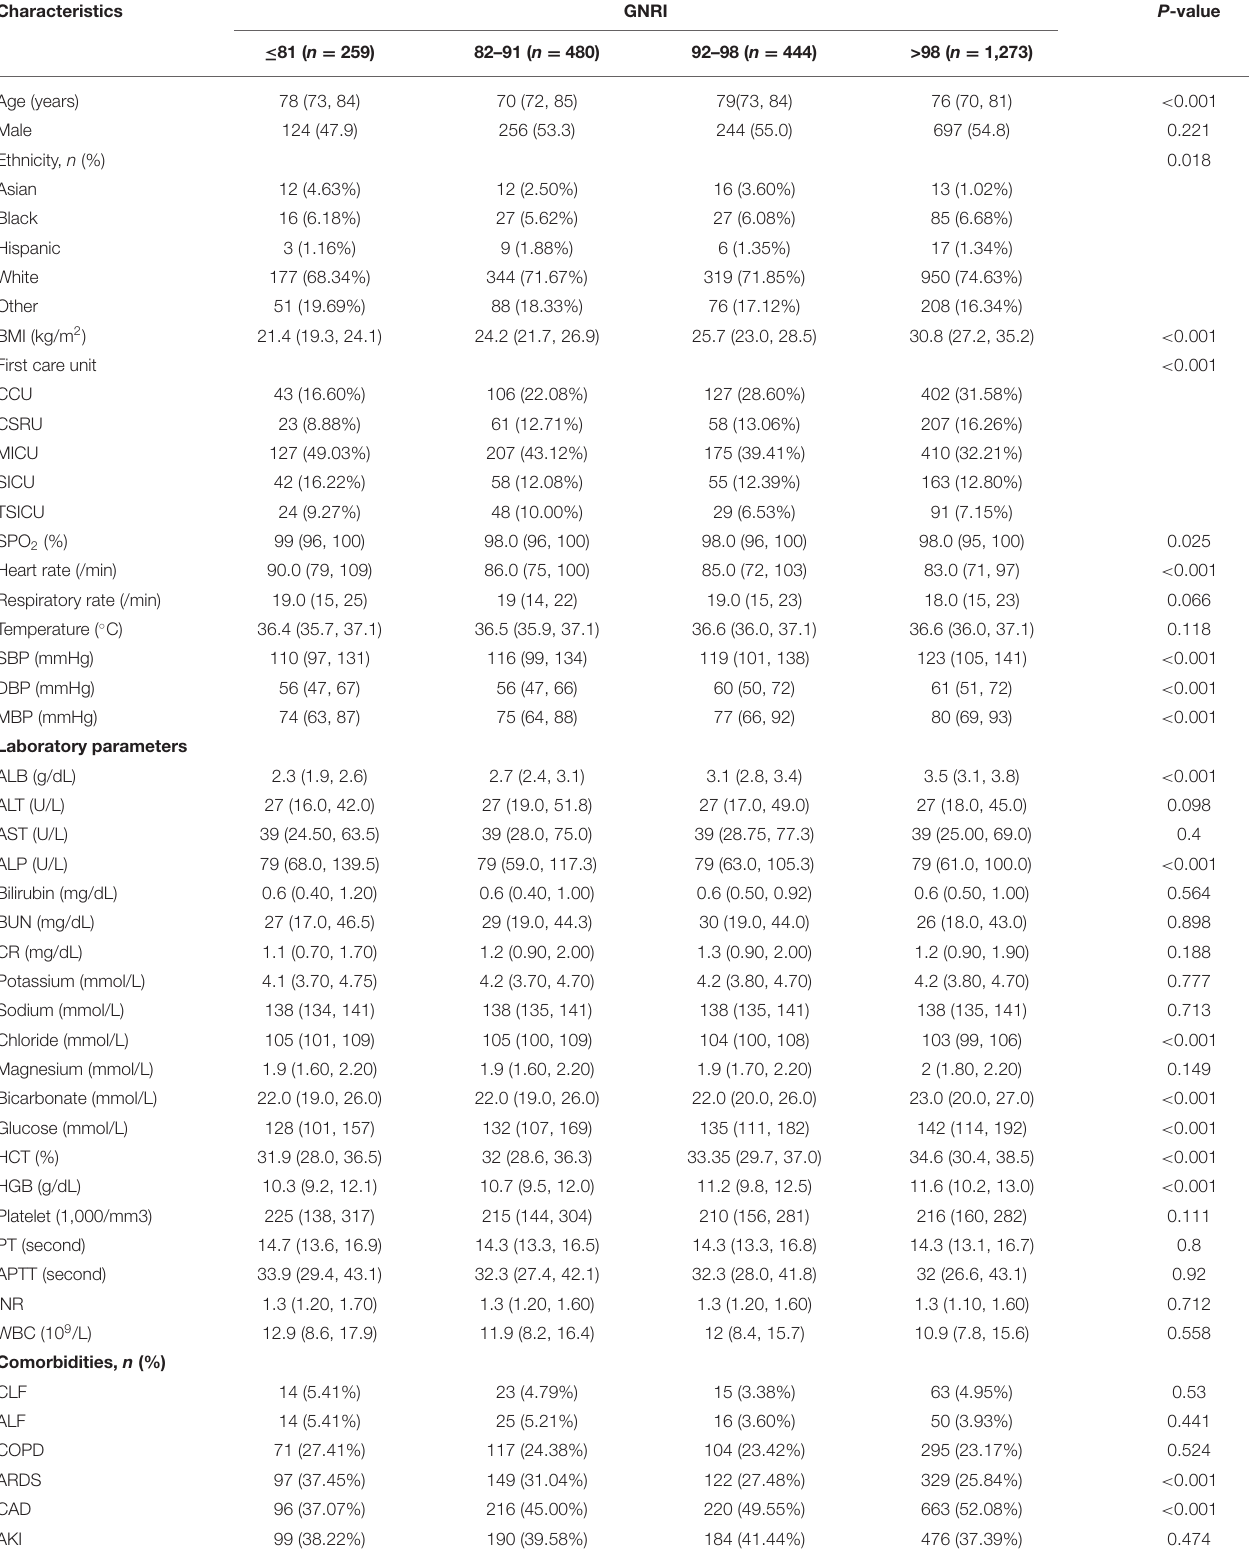
TABLE 2 | Characteristics of patients in subgroups with different GNRIs.